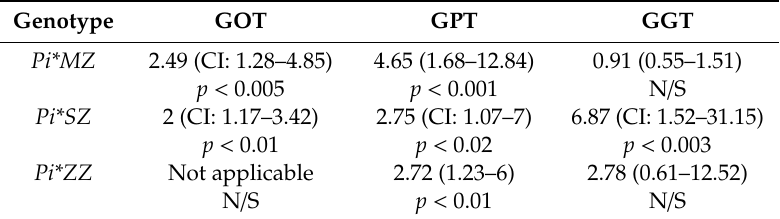
Table 2. Odds ratio relationship between the genotypes that include the PI*Z allele and the serum transaminase levels. GOT: glutamate-oxaloacetate transaminase. GPT: glutamate-pyruvate transaminase. GGT: gamma-glutamyl transpeptidase. N/S: not significant.